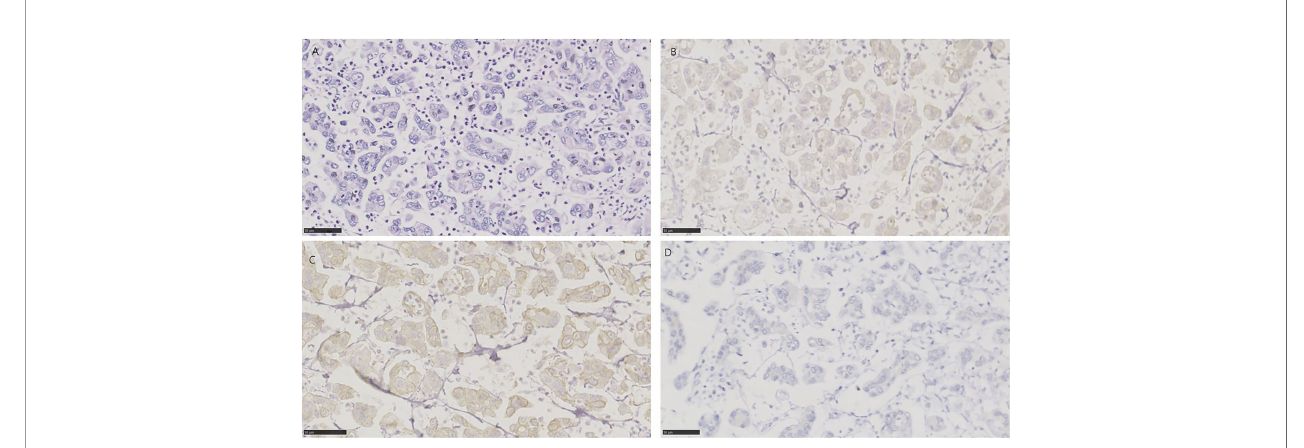
FIGURE 6 | HE and immunohistochemistry for HER2, TROP-2, and NECTIN-4 in micropapillary urothelial carcinoma. Scale bar: 50 µm. (A) HE-stained section of micropapillary urothelial carcinoma. (B) Immunohistochemistry for NECTIN-4 in the same tumor showing weak staining. (C) Immunohistochemistry for TROP-2 in same tumor showing moderate staining. (D) Immunohistochemistry for HER2 in the same tumor showing negative.